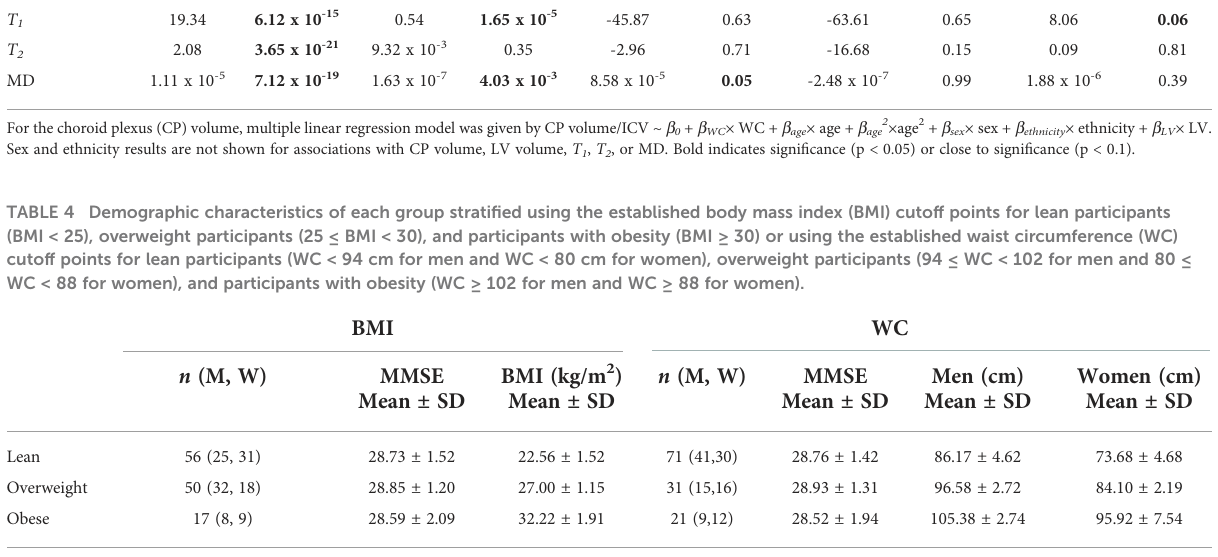
TABLE 5 Signi fi cance, p -value, of the between-group ANCOVA analyses of the effect of body mass index (BMI) or waist circumference (WC) on lateral ventricle (LV) volume/intracranial volume (ICV), T 1 , T 2 , or mean diffusivity (MD). Obese vs. Lean Overweight vs. Lean Obese vs. Overweight